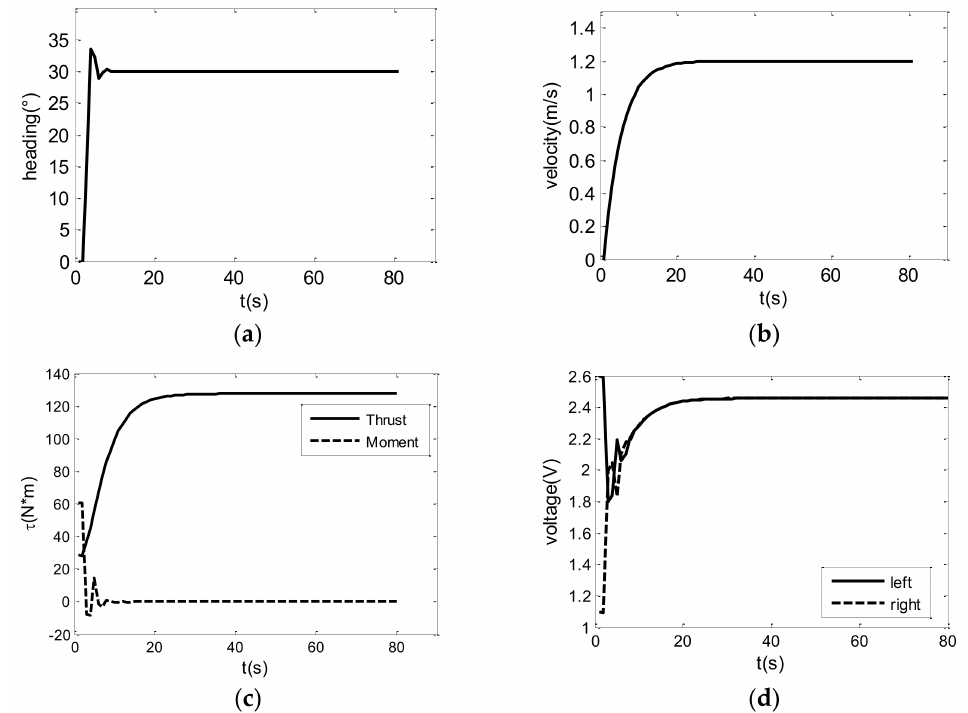
Figure 3. Simulation results of 30 ◦ heading control and 1.2 m/s velocity control: ( a ) actual heading of the USV; ( b ) actual velocity of the USV; ( c ) thrust and moment of the propellers; and ( d ) control voltage of the propeller